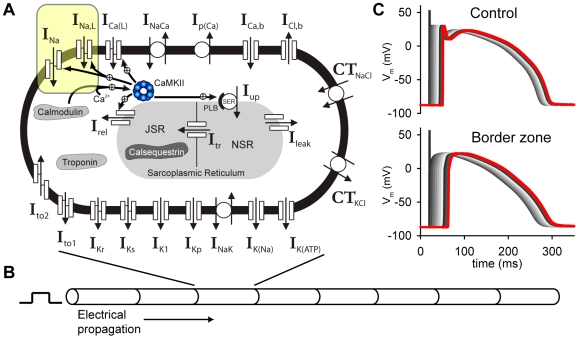
Mathematical model of cardiac action potential and electrical conduction.(A) Hund-Rudy dynamic (HRd) canine ventricular epicardial cell model. Symbols are defined in text and in Table S1. (B) One-dimensional fiber model comprised of individual cells electrically coupled through gap junctions. A current stimulus is applied at the end of the fiber (cell 1) and the excitation wavefront propagates down the fiber. (C) Simulated action potentials from every 20th cell in the control (top) and border zone (bottom) fibers.